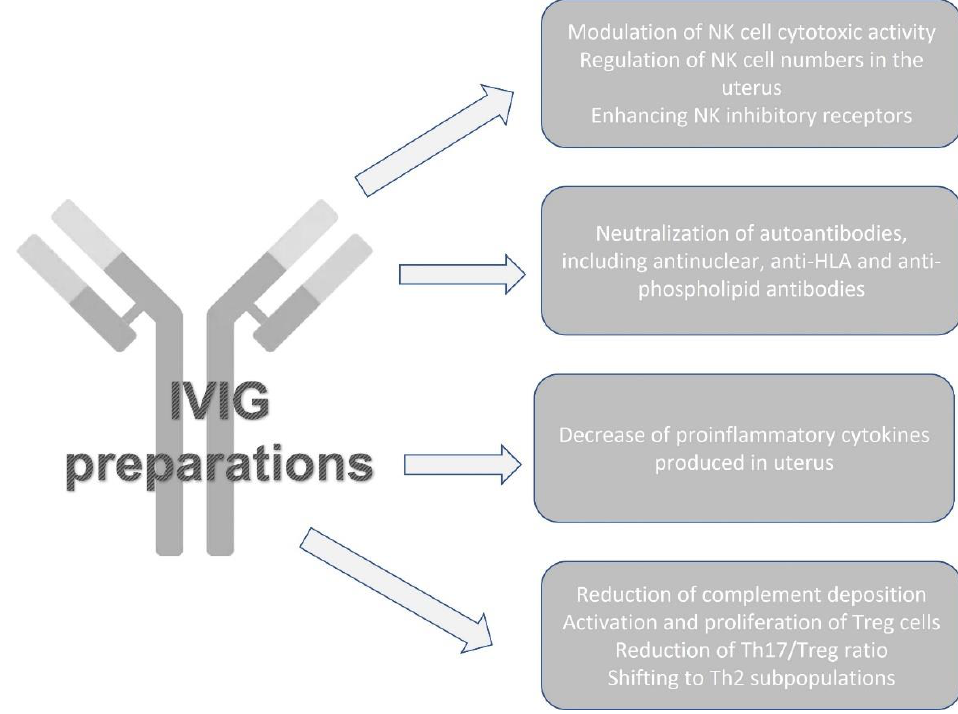
Figure 2. Effects of IVIG therapy on immune mechanisms associated with reproductive failure. IVIG-treated recurrent pregnancy losses (RPL) patients had lower Th1/Th2 and Th17/Treg cell ratios than untreated patients. IVIGs reduced the Th17/Treg cell ratio in low-quartile women [123 – 125].